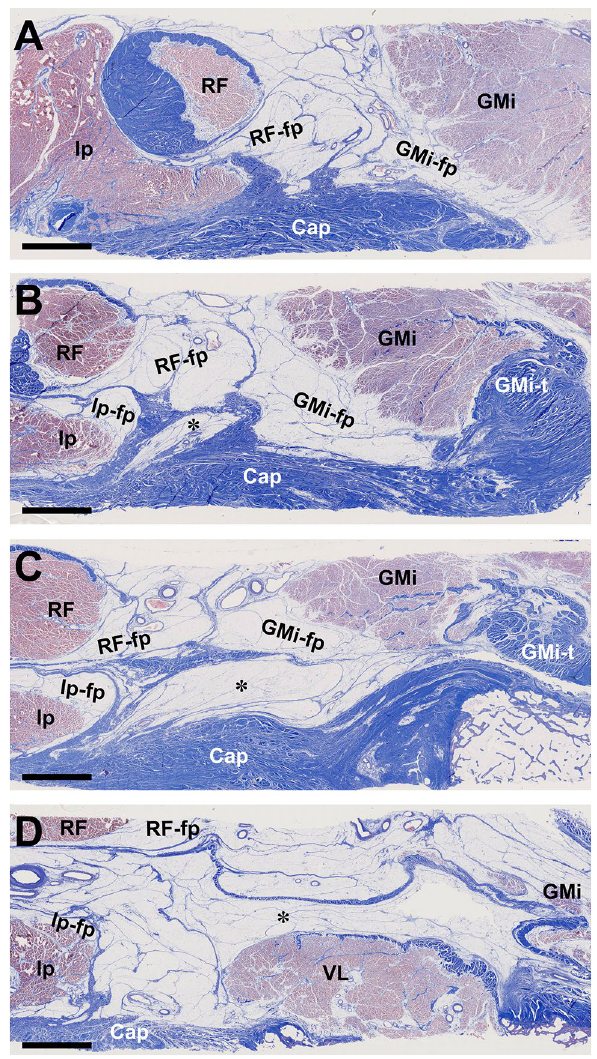
Figure 3. Histological distribution of loose connective tissue on the anterior region of the joint capsule (Masson’s trichrome staining). Histological sections of the boxed region in Fig. 1B–E are shown in ( A – D ), respectively. The fat pad is segmented by a dense connective tissue and roughly divided into fat pad segments deep to the rectus femoris (RF-fp), medial to the gluteus minimus (GMi-fp), lateral to the iliopsoas (Ip-fp), and superficial to the joint capsule and vastus lateralis (indicated by asterisk). Scale bars = 5 mm. Cap joint capsule; GMi gluteus minimus, GMi-t GMi tendon, Ip iliopsoas, RF rectus femoris, VL vastus